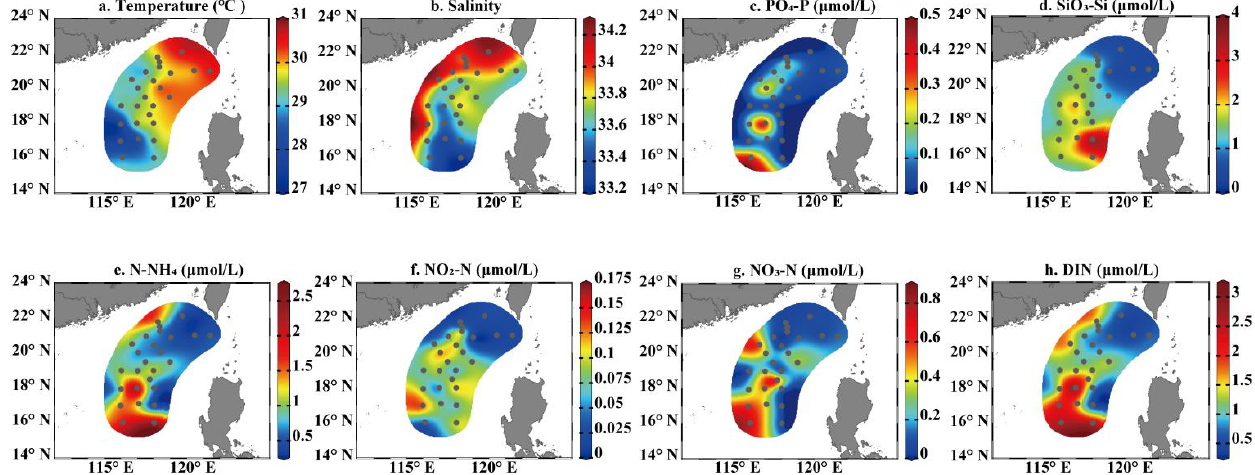
Figure 2. Surface distribution of environmental variables in NESCS. Table 1. Range and mean ± SD of environmental variables in three contrasting sections.